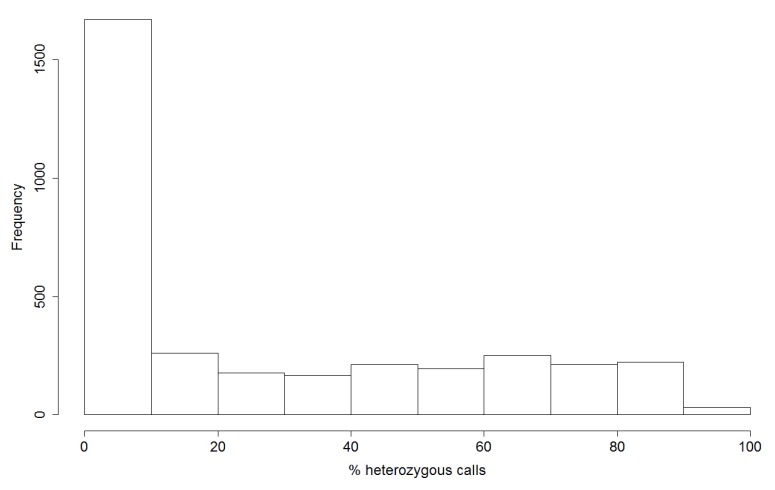
The frequency distribution of percentage heterozygous calls in samples.About half of the 3,394 samples showed percentage heterozygous calls less than ten percent and were defined as single strain samples. Rest of the samples showed roughly uniform distribution of percentage heterozygous calls and were defined as mixed strain samples.